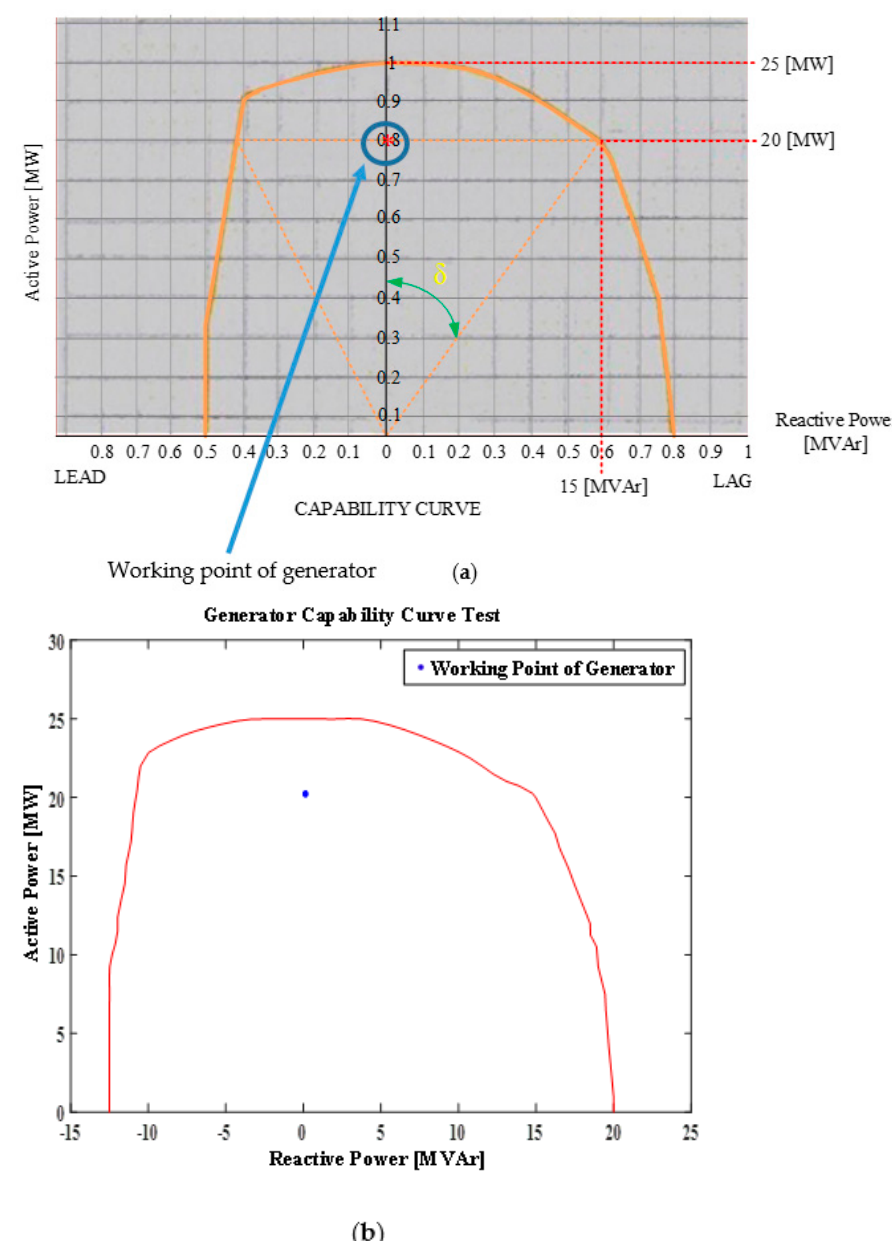
Figure 18. Original capability curve from the generator in Lahendong IV geothermal power plant. The enhanced figure of the generator capability curve is shown in Figure 19a. A com- parison of the original generator capability curves and the simulation results for the third testing is shown in Figure 19.